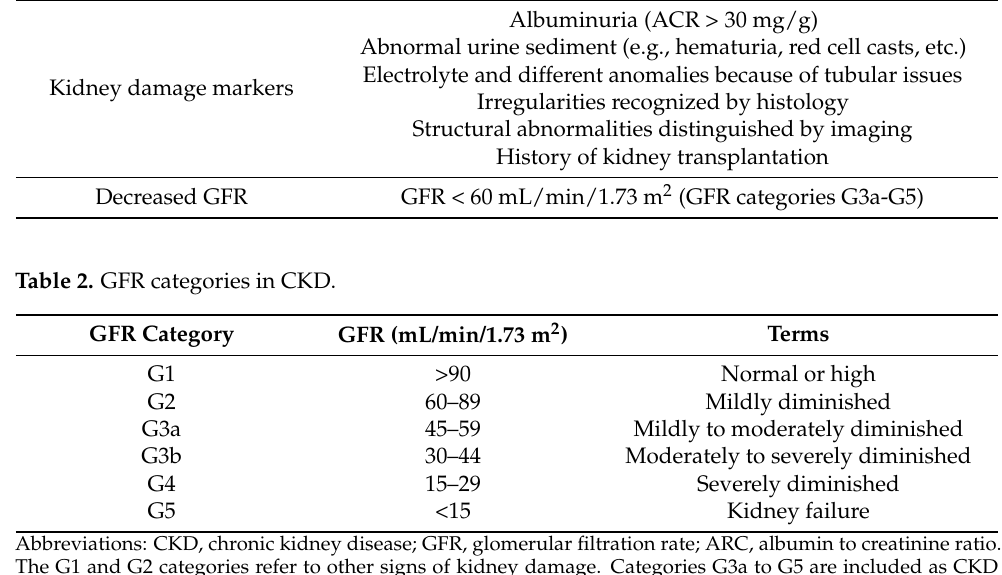
Table 1. CKD criteria (present for more than 3 months).